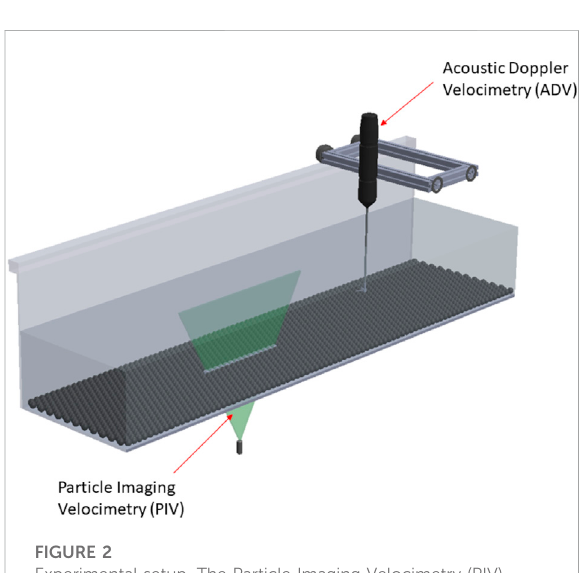
FIGURE 2 Experimental setup. The Particle Imaging Velocimetry (PIV) and Acoustic Doppler Velocimetry (ADV) were used to measure fl ow properties.